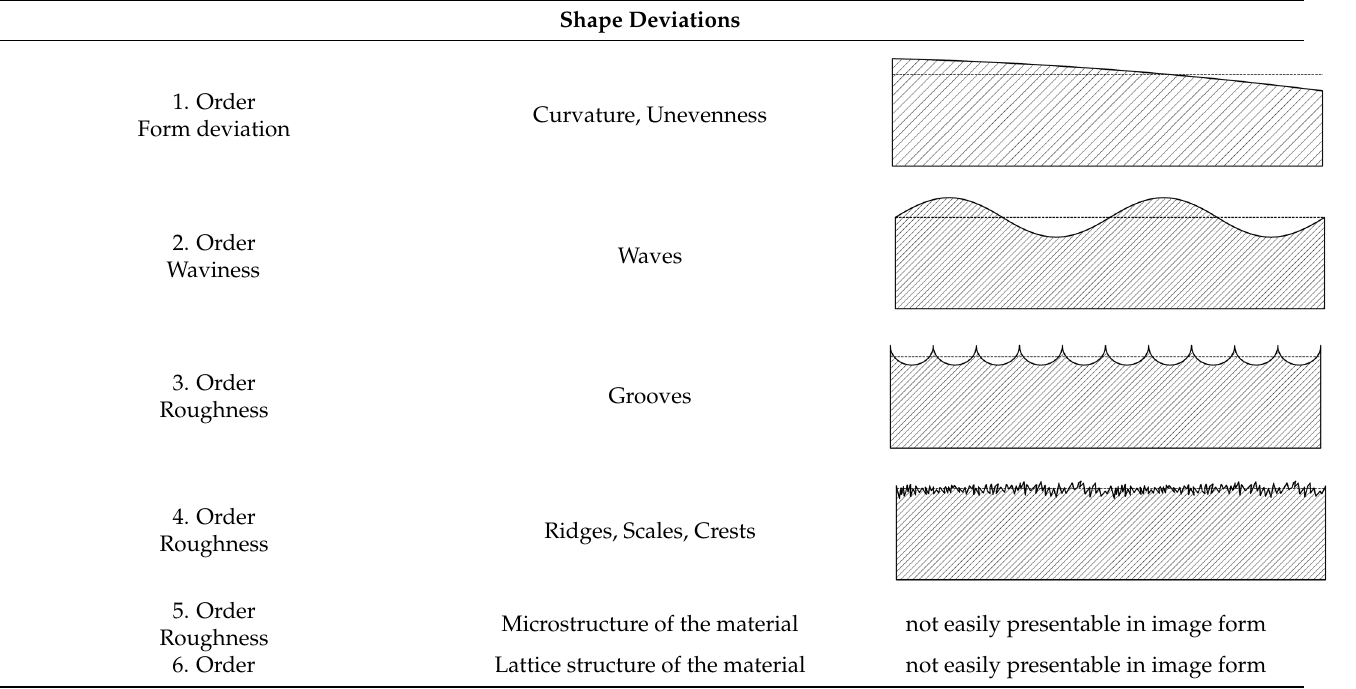
Table 1. Shape deviations of technical surfaces (according to the German standard DIN 4760).